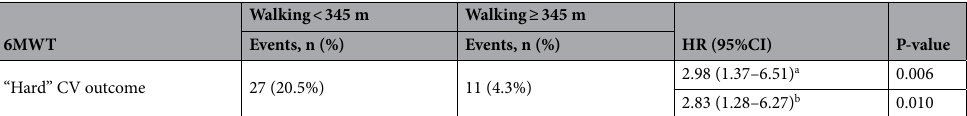
Walking < 345 m Walking ≥ 345 m